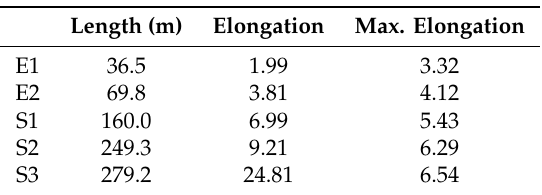
Table 2. Lengths and elongations of drumlins on the Ecology Glacier foreland and the Sphinx Glacier foreland juxtaposed with maximum elongation according to Clark et al. [82]. Length (m) Elongation Max.